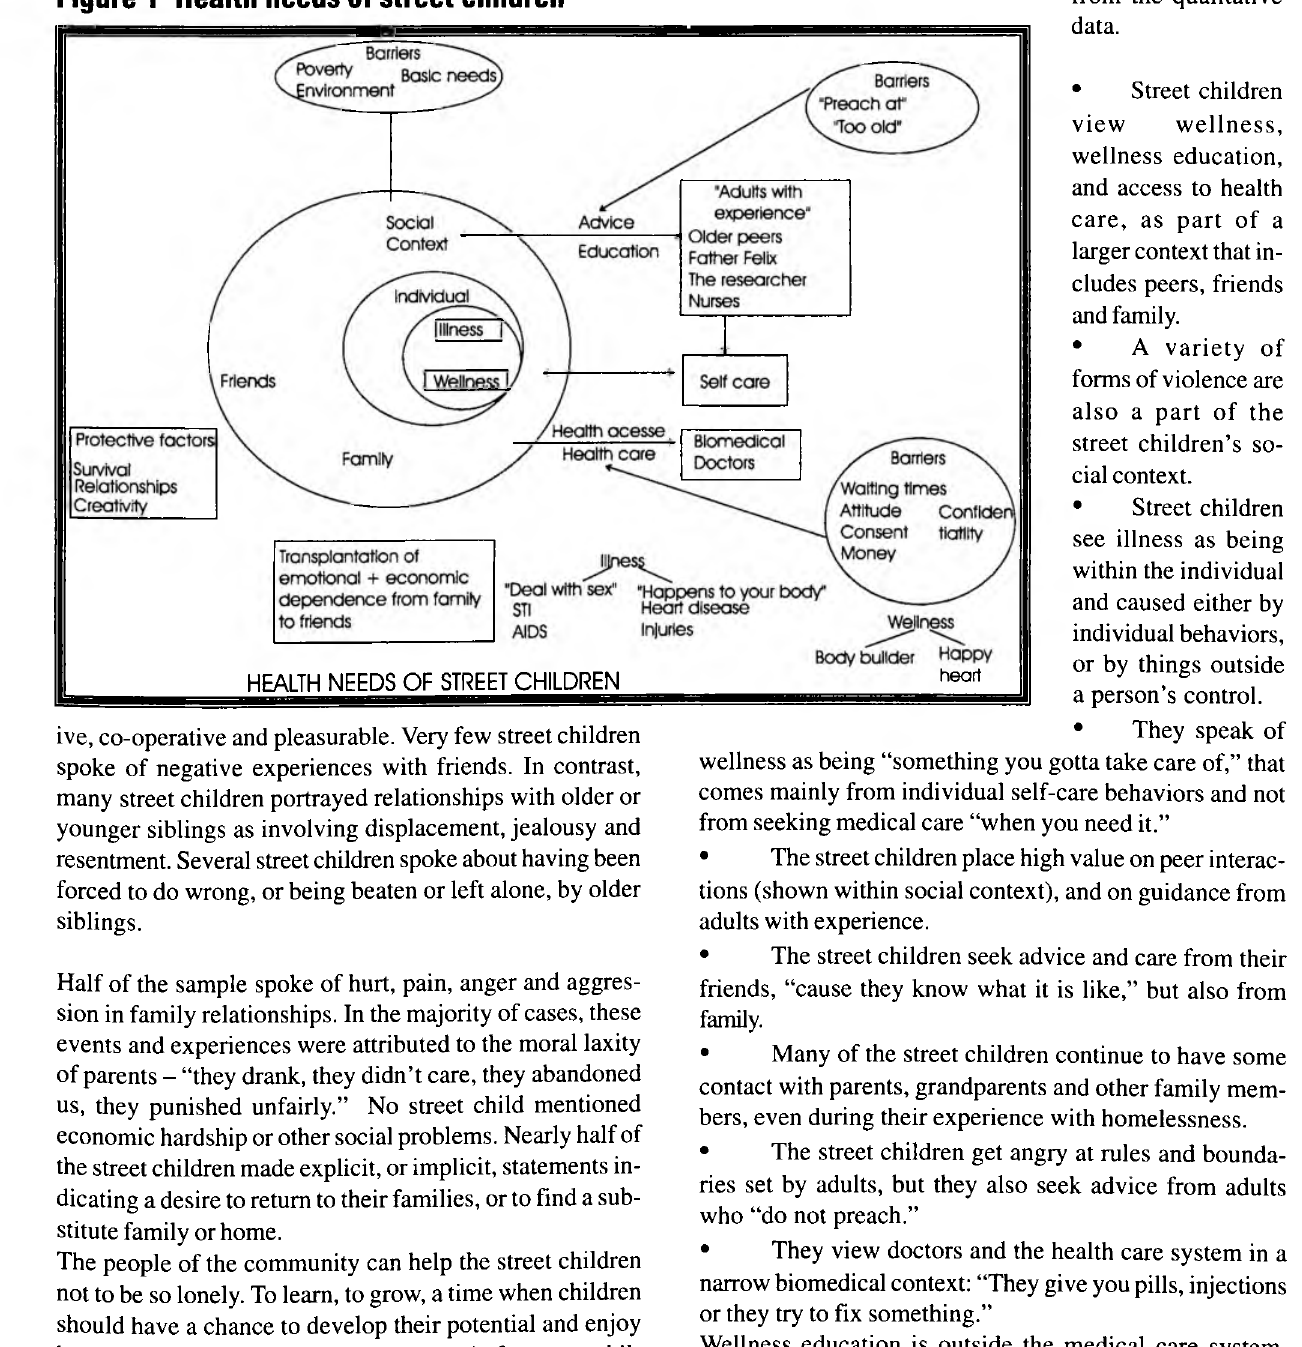
Figure 1 Health needs of street